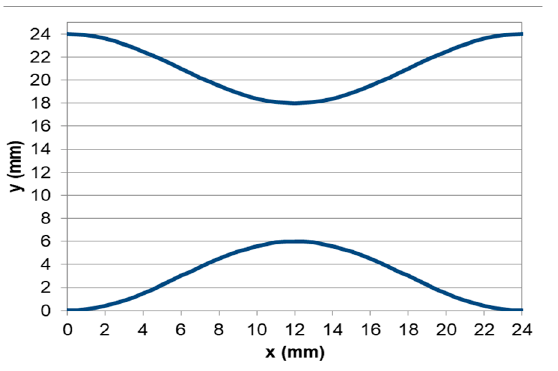
Figure 3. The two curves of stenosis.